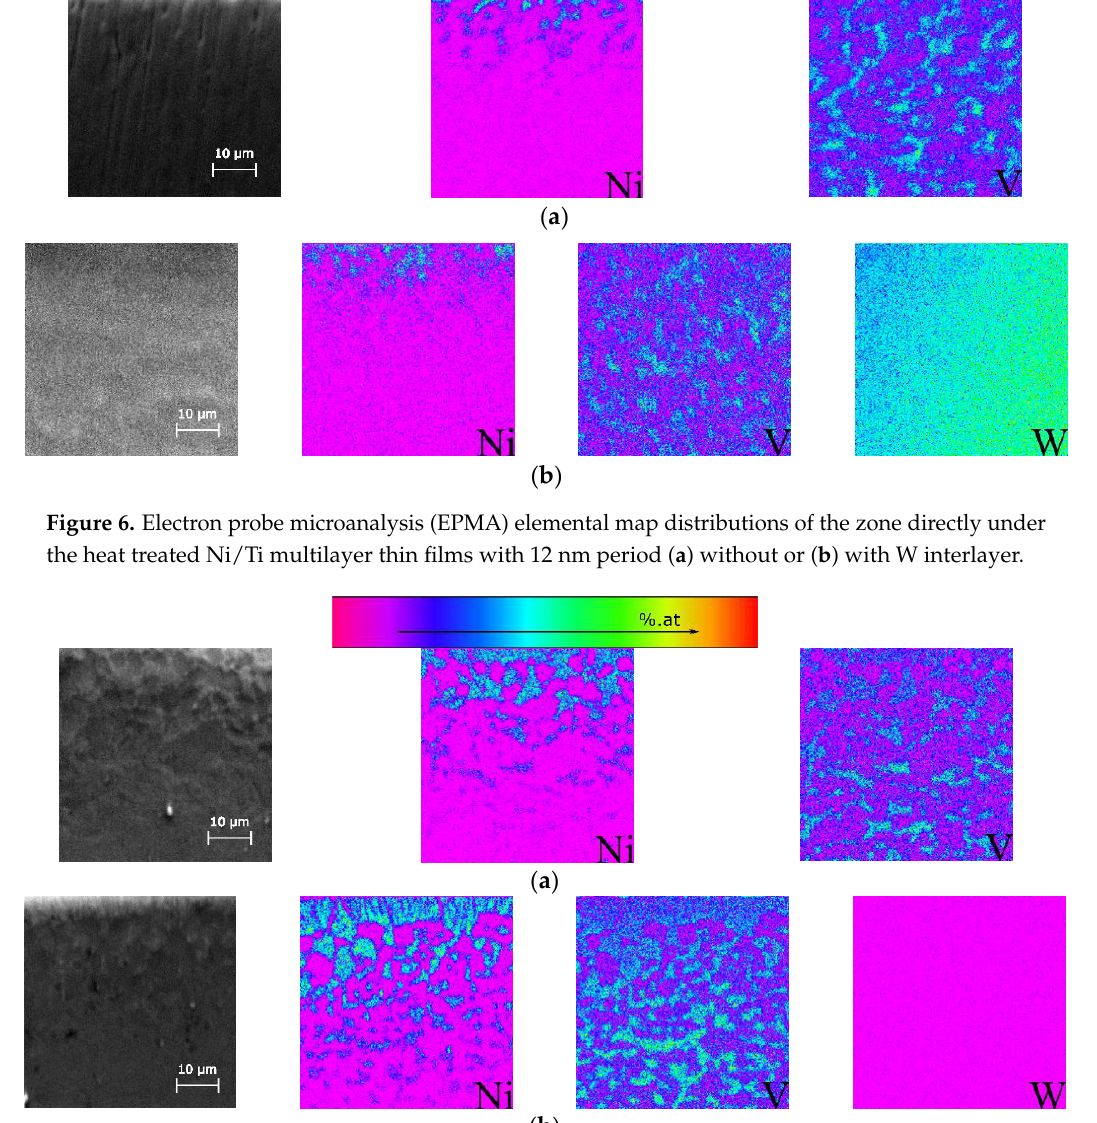
Figure 7. EPMA elemental map distributions of the zone directly under the heat treated Ni/Ti multilayer thin films with 25 nm period ( a ) without or ( b ) with W interlayer.